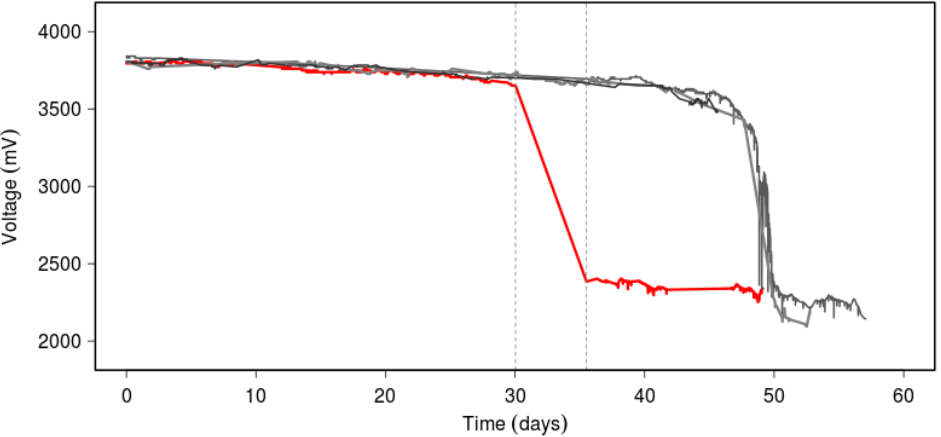
Figure 18. Four battery discharge curves for node 2150 (Site 2) representing normal and truncated battery life. The red line depicts the rapid depletion of battery power during a gateway outage (indicated between the two vertical dashed